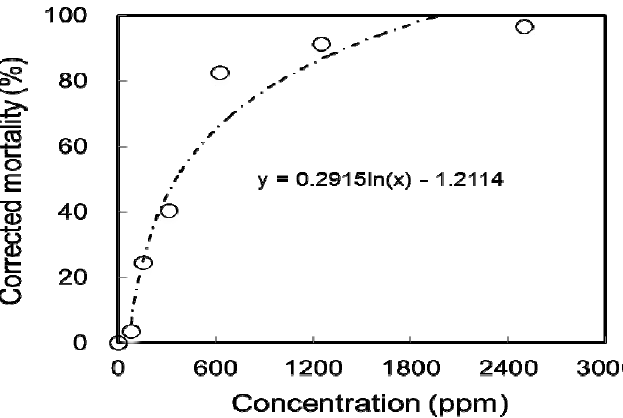
Figure 3. Toxicity of the extract against Tribolium castaneum .